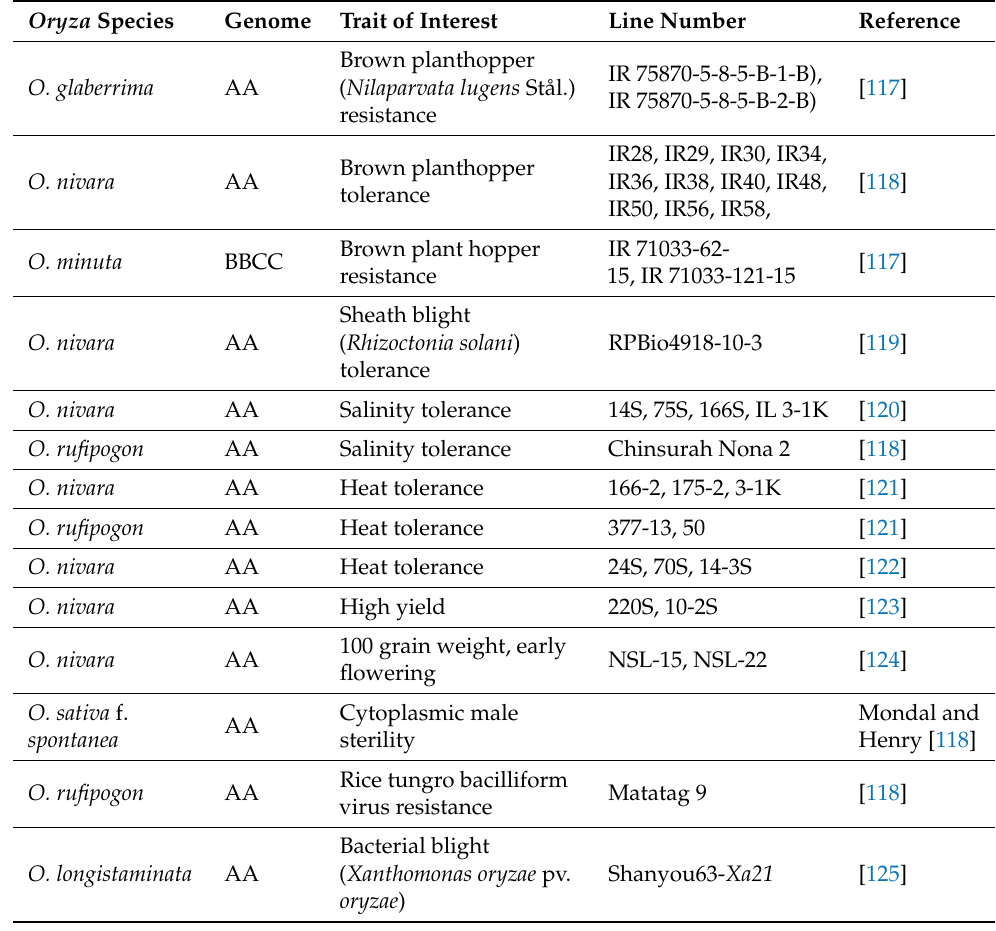
Table 3. Some examples of traits of wild rice used in improving Oryza sativa —the cultivated species of